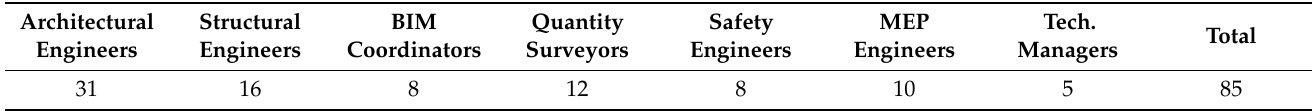
Table 2. Sample of engineers/specialists.